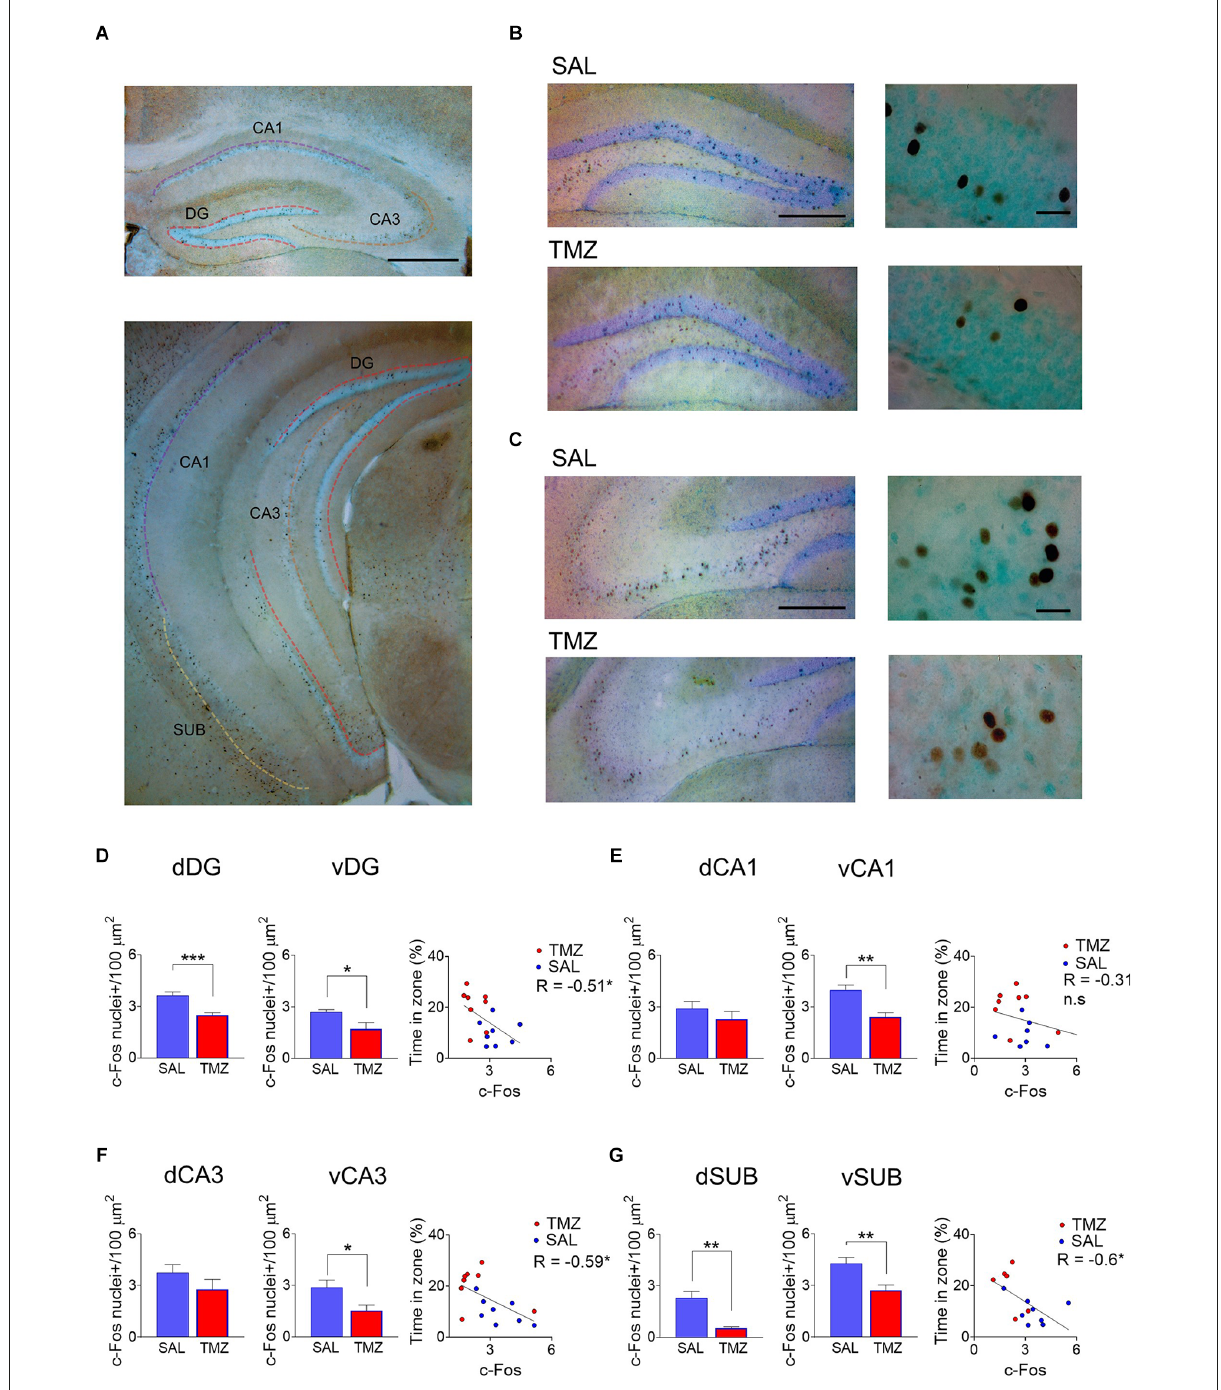
FIGURE3 The activity levels in the hippocampus at the second probe test were evaluated by quantifying immediate early gene expression c-Fos positive nuclei. The hippocampus was subdivided in dorsal and ventral divisions and in its different layers dCA1, vCA1, dCA3, vCA3, dDG, vDG, dorsal subiculum (dSUB), ventral subiculum (vSUB). (A) Here it is shown a representative picture of low and high magnification of both Dentate gyrus granule cell layer (B) as CA3 pyramidal layer (C) in both areas is notorious a conspicuous c-Fos expression in the whole area and exclusively in the nuclear and perinuclear zone of the cells. Qualitatively more cells are observed in the SAL pictures vs. the TMZ groups. In both the hippocampus’s dorsal and ventral divisions, the SAL animals have a higher density of c-Fos+ cells. Linear regression analysis showed a negative correlation between the density of c-Fos+ cells and the time the mice spent in the target zone in the water maze at the second probe test (D) . In